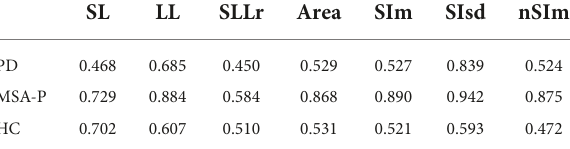
TABLE 2 The intraclass correlation coefficient of two radiologists’